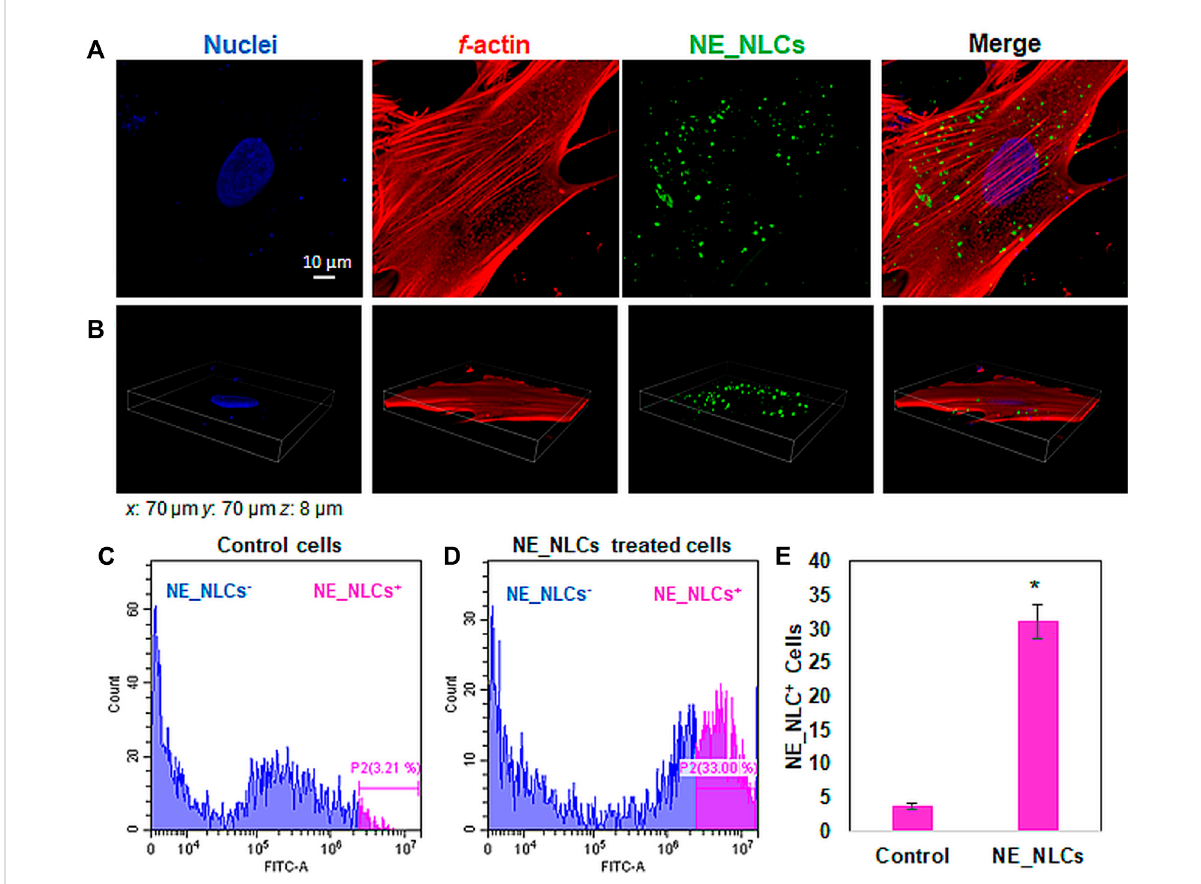
FIGURE 4 Representative confocal imagesofHDFstreated for 24 hwith NE_NLCs 100 μ g/ml(NE_NLCsin green,f-actin inred,and nuclei inblue): single z -stack (A) and 3D rendering (B) images. Representative fl ow cytometry results of control (C) and NE_NLCs-treated (D) HDFs, as well as quantitative analysis (E) . Data are represented as mean values ±standard deviation ( n = 3; * p <